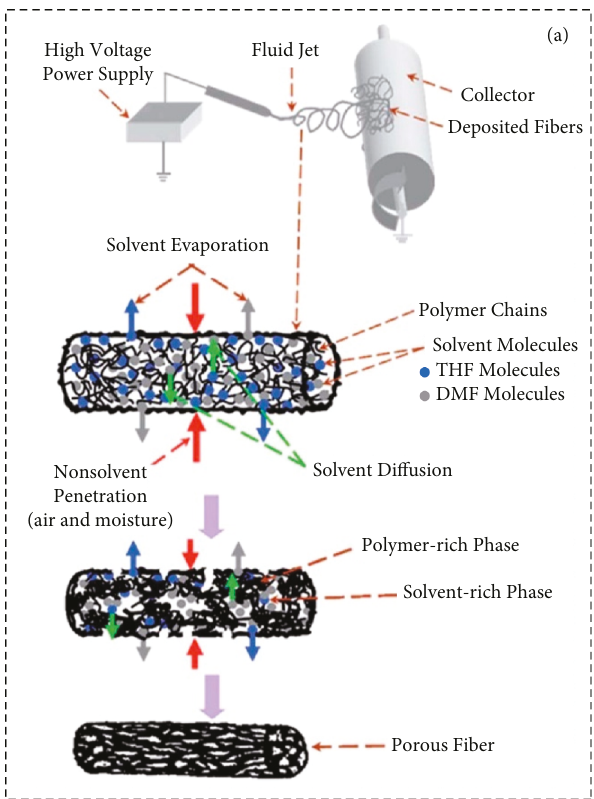
Figure 7: Schematic diagram illustrating the formation process of porous fibers during electrospinning